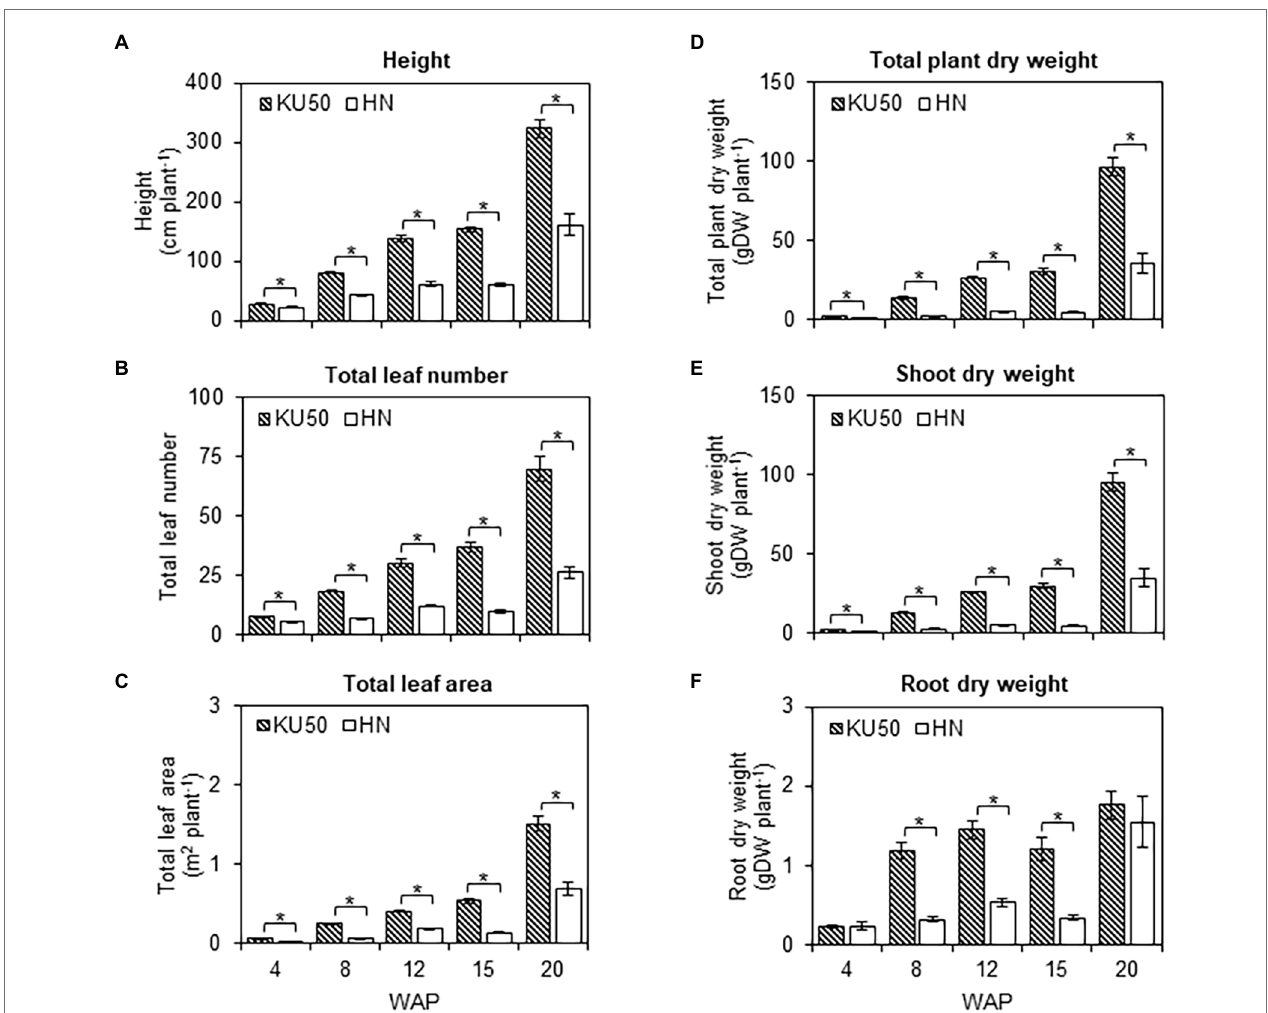
FIGURE 6 | (A) Height, (B) total leaf number, (C) total leaf area, (D) total plant dry weight, (E) shoot dry weight, and (F) root dry weight of KU50 and HN cassava varieties at various developmental stages. Each result is the mean ± SE of values obtained from 15 biological replicates at 4, 8, and 12 WAP, and from 12